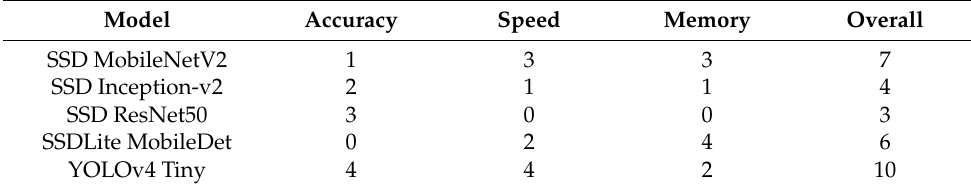
Table 11. Global comparison between the models.